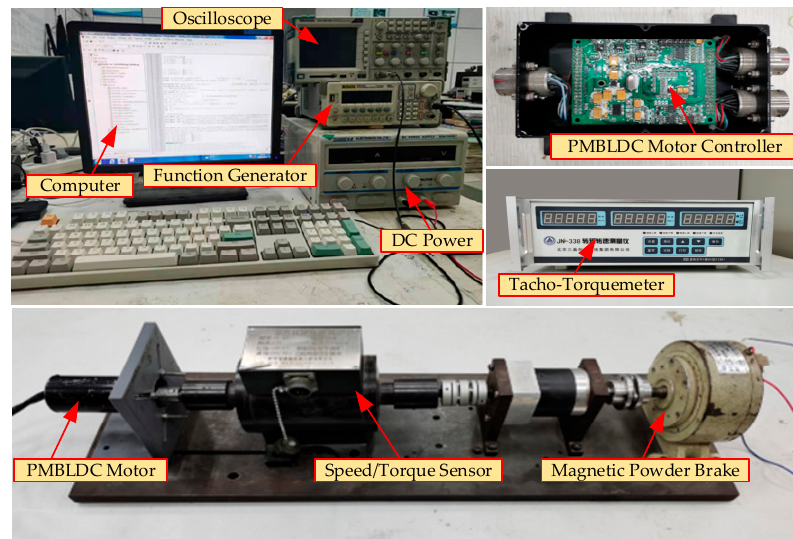
Figure 11. Experimental Platform.